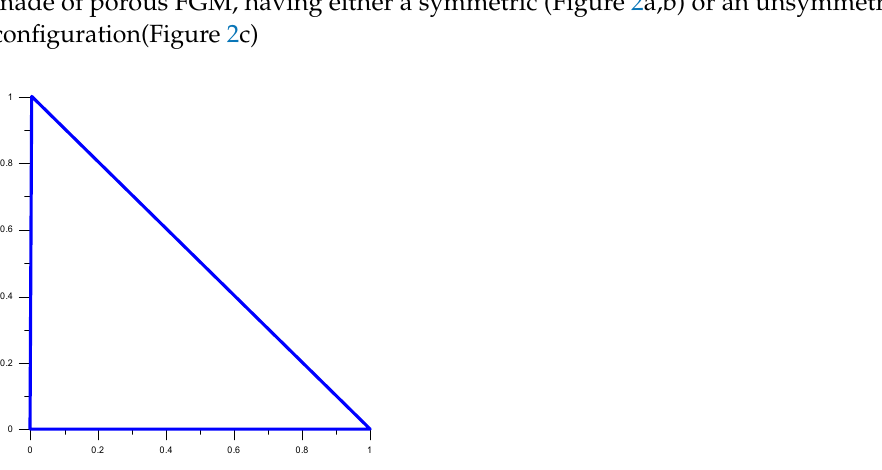
Figure 1. Geometry of the analyzed normalized right plates.